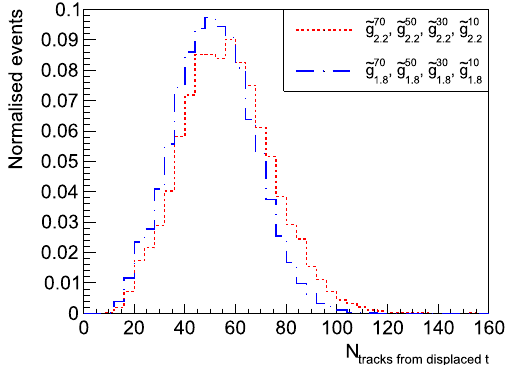
Fig. 67 MissingtransverseenergyMETinthegluino ˜ g case.Themain contribution is coming from the invisible neutralino